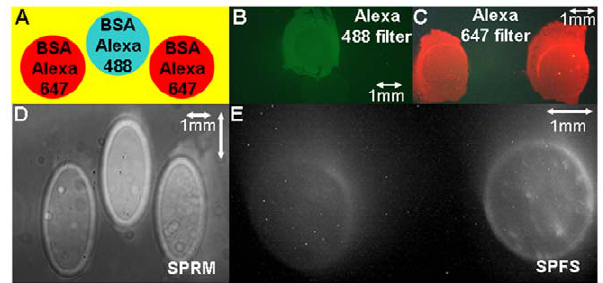
Figure 3. Fluorescence Component Testing. A) Illustrating the schematic of the pattern spotted on the Au-coated slide. B) and C) Images observed through conventional epifluorescence microscopes with filters for Alexa 488 and Alexa 647. D) SPRM Image: all three spots are seen since the SPRM detects the change in the refractive index due to deposition of the BSA. Image is compressed in the x-axis due to the high incident angle of the incoming light. E) SPRF image: only 2 spots, those with Alexa Fluor 647 are seen in the SPRF image.